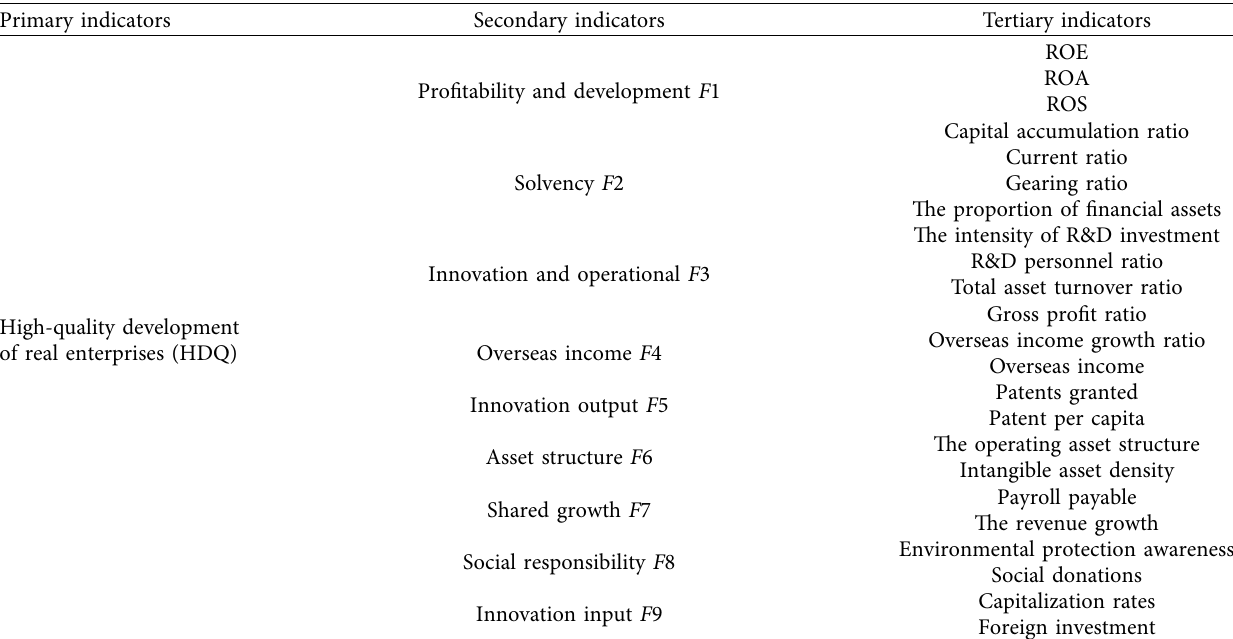
Table 7: Evaluation hierarchy model.